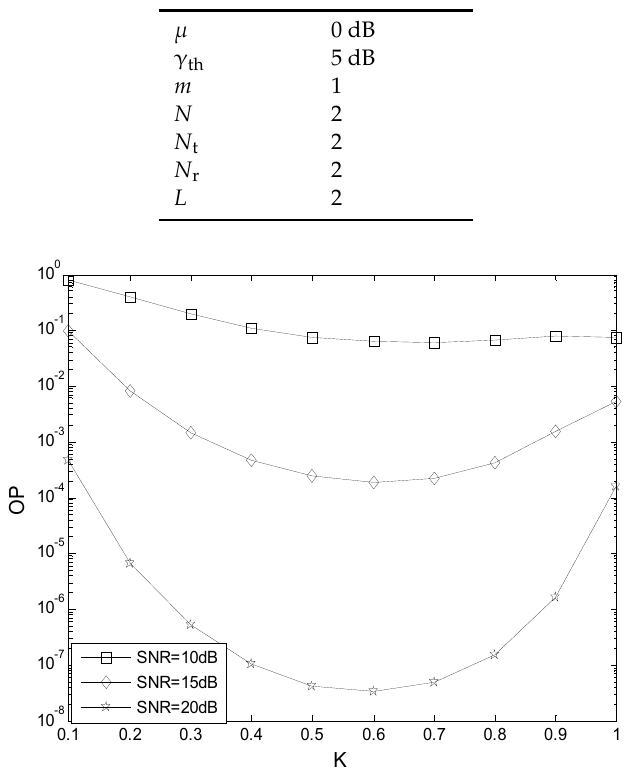
Table 3. The parameters for the TAS scheme.